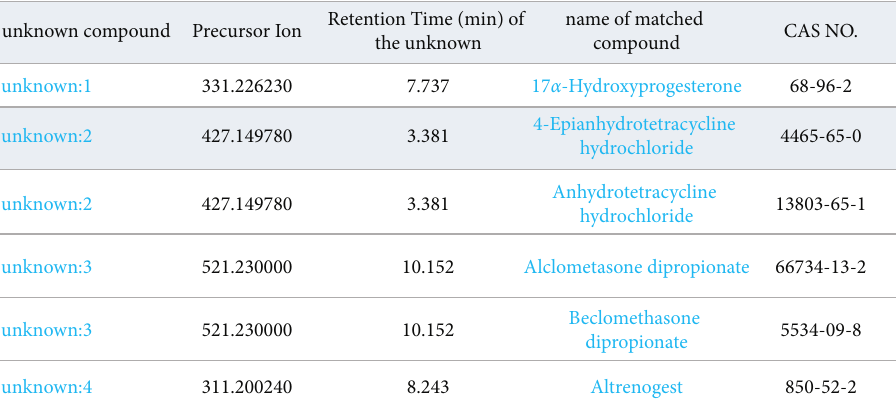
Figure 2: Screening results summary page (part 1). The page contains part of the information of the compound matched by the unknown object according to the algorithm.